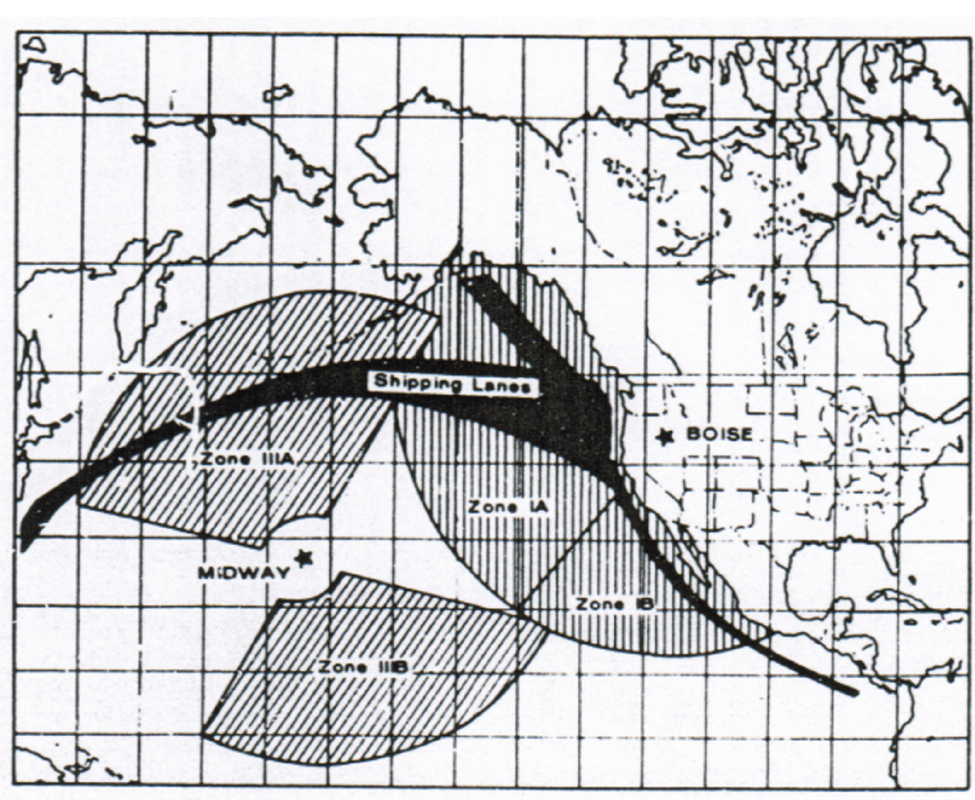
Figure 25. Proposed sites and nominal coverage for Pacific radars envisaged by Rhodes and Chad- wick [101].